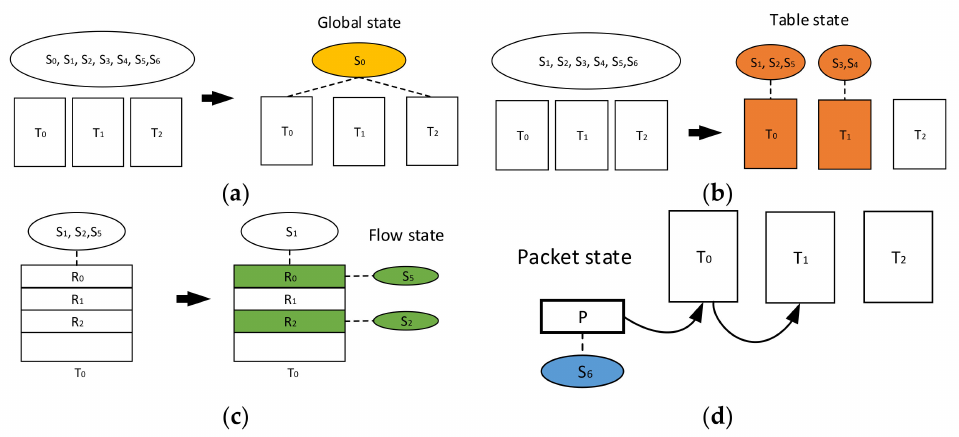
Figure 3. Fine-grained state division via a multilevel match–action table structure. ( a ) global state; ( b ) table state; ( c ) Flow state; ( d ) Packet